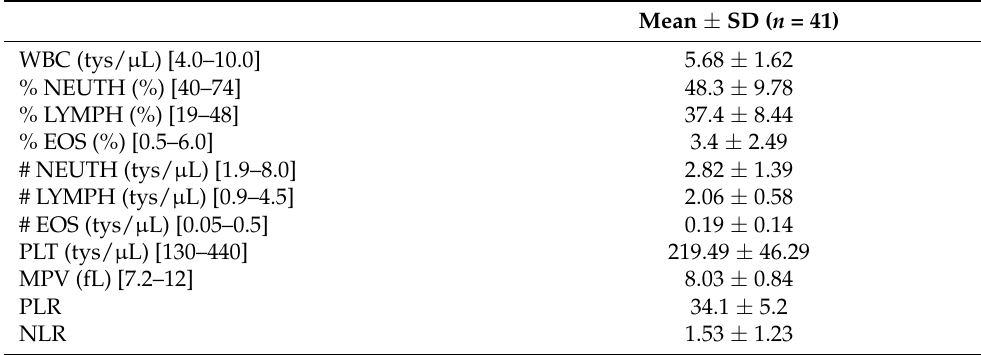
Table 2. Hemogram parameters of the study